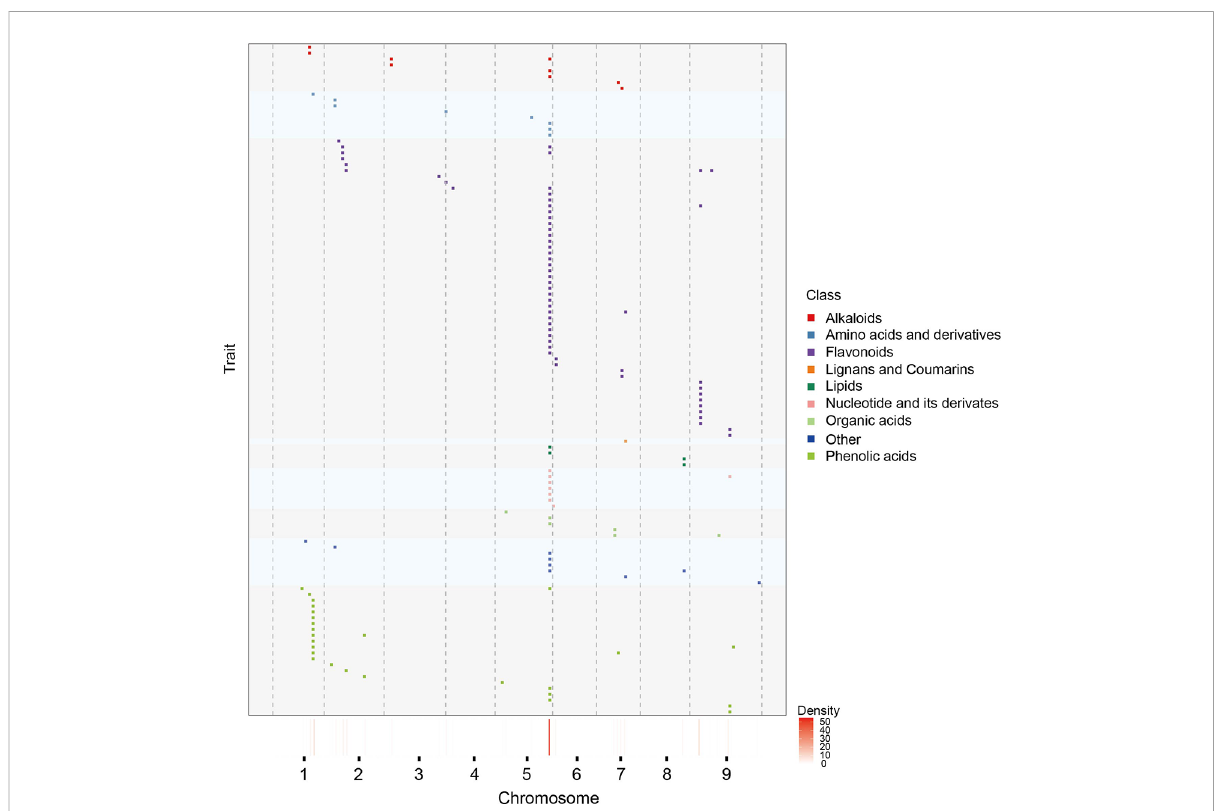
FIGURE 2 Chromosomal distribution of mQTLs identic fi ed from annotated metabolites. Distribution of mQTLs of 467 known metabolites on chromosomes. Each row represents the QTL mapping of single metabolic traits. Metabolites from different class are marked by distinct colours. The x-axis indicates the positions across the millet genome. The heatmap under the x-axis illustrates the density of QTL across the genome. The window size is 3